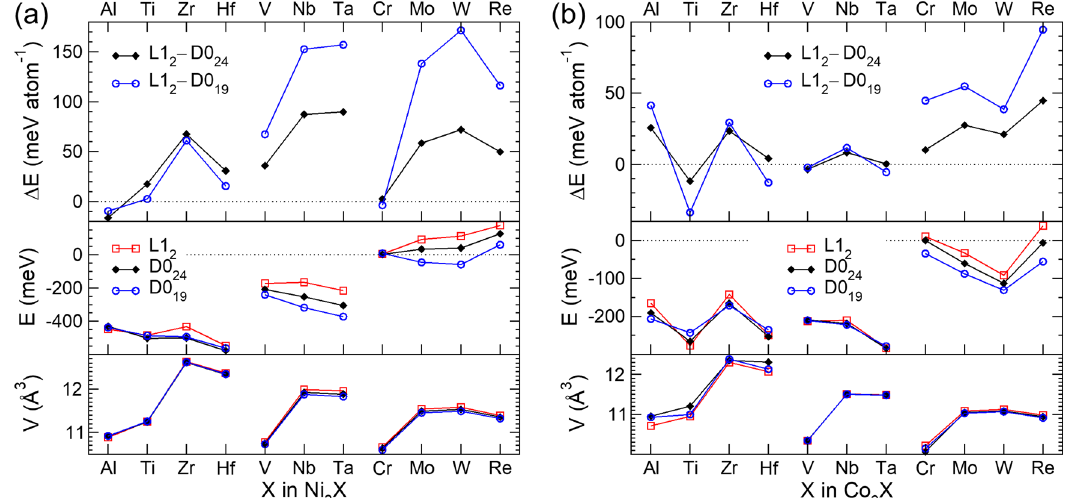
Fig. 6 DFT calculation results. Computed energy differences, formation energies (relative to the ground states of elemental solids), and volume per atom of L12 ( γ ʹ ), D019 ( χ ), and D024 ( η ) structures, fully relaxed at zero pressure, for ( a ) binary Ni3X line compounds in nickel-based superalloys and ( b ) Co3X line compounds in cobalt-based superalloys with X = {Al, Ti, Zr, Hf, V, Nb, Ta, Cr, Mo, W, Re}. Elements are arranged by their group in the periodic table. Lines are only a guide to the eye.